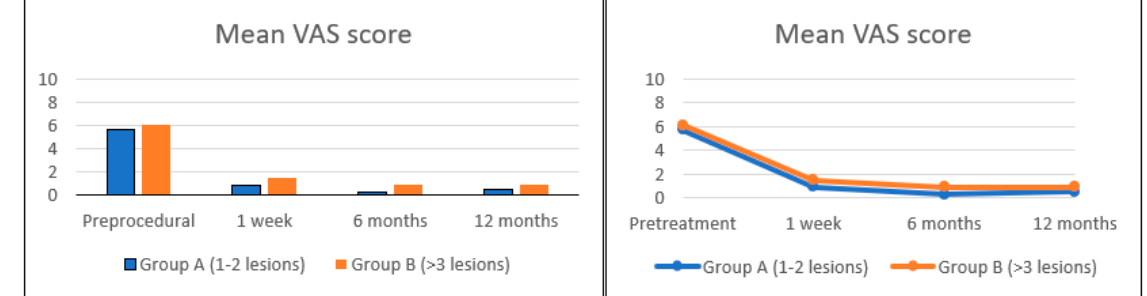
Figure 5. Evaluation of VAS score in symptomatic patients across Group A and Group B, before tRFA, 1 week, 6 months, and 12 months after tRFA.